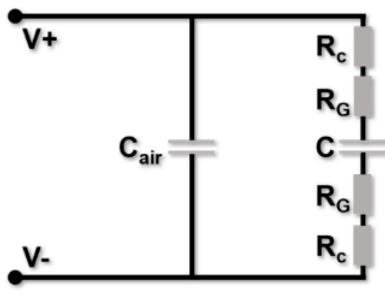
Figure 13. The equivalent circuit model.